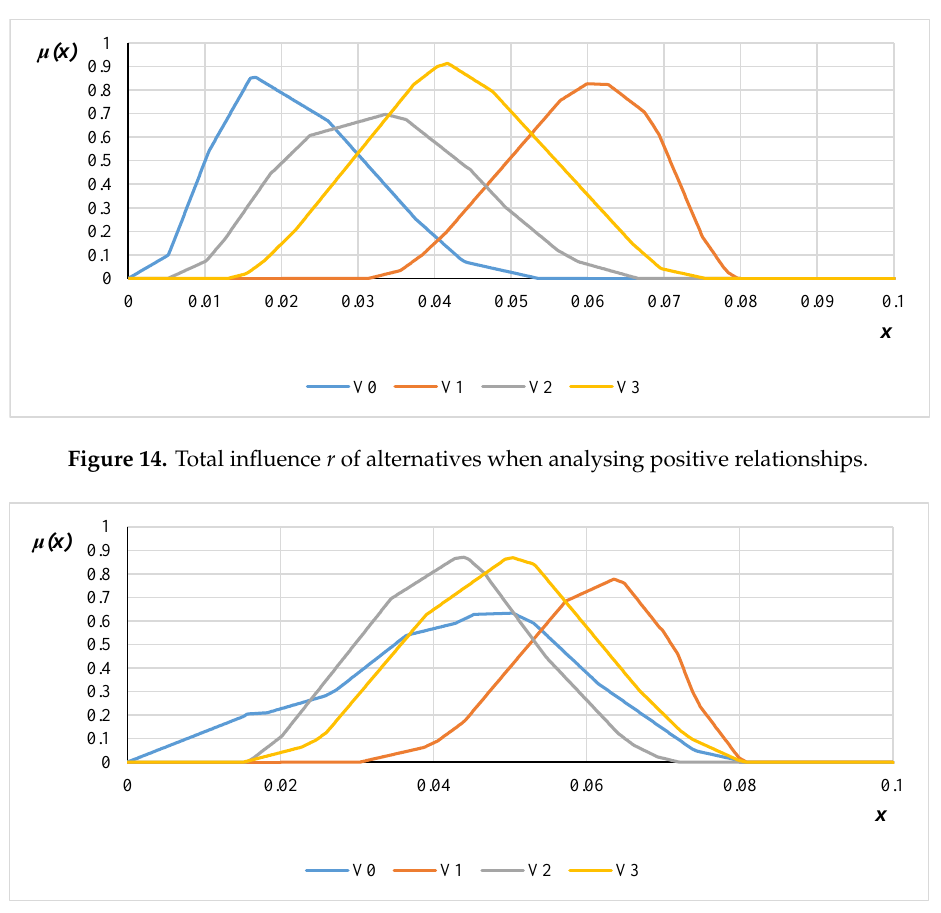
Figure 13. Significance of individual criteria according to expert assessment (E1, E2,…,E5 – experts). A